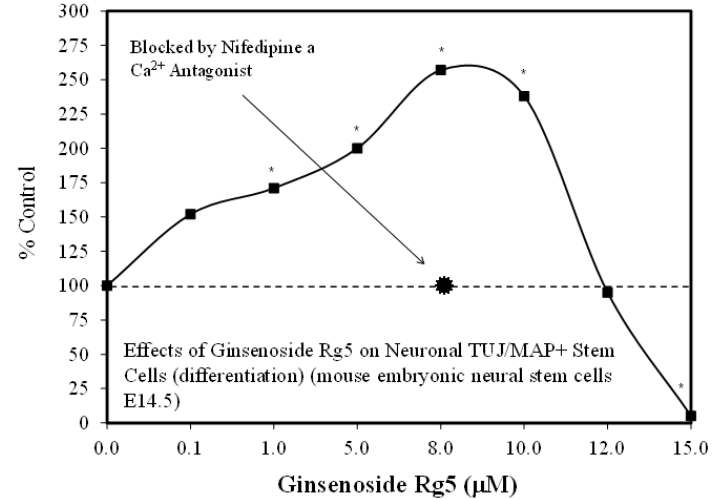
Figure 2. E ff ects of ginsenoside Rg5 on neuronal TUJ / MAP + stem cells (di ff erentiation) (mouse Figure 2. Effects of ginsenoside Rg5 on neuronal TUJ/MAP+ stem cells (differentiation) (mouse embryonic neural stem cells E14.5) (source: [33]). * = statistically embryonic neural stem cells E14.5) (source: [33]). * = statistically significant